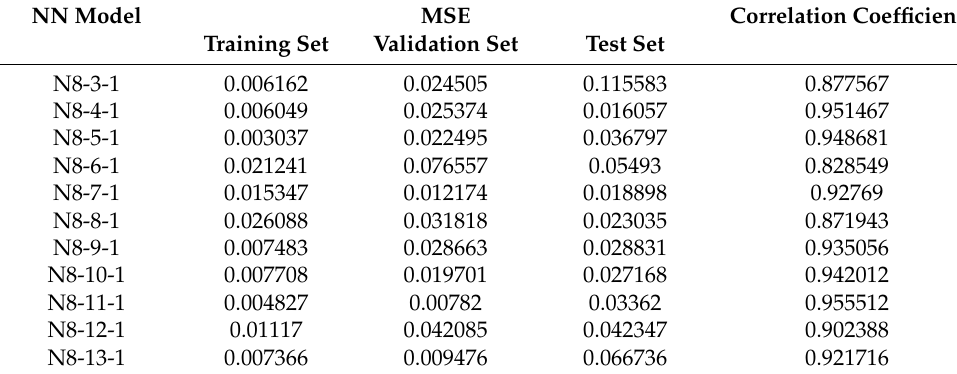
Table 2. Performance value of Yield Displacement.